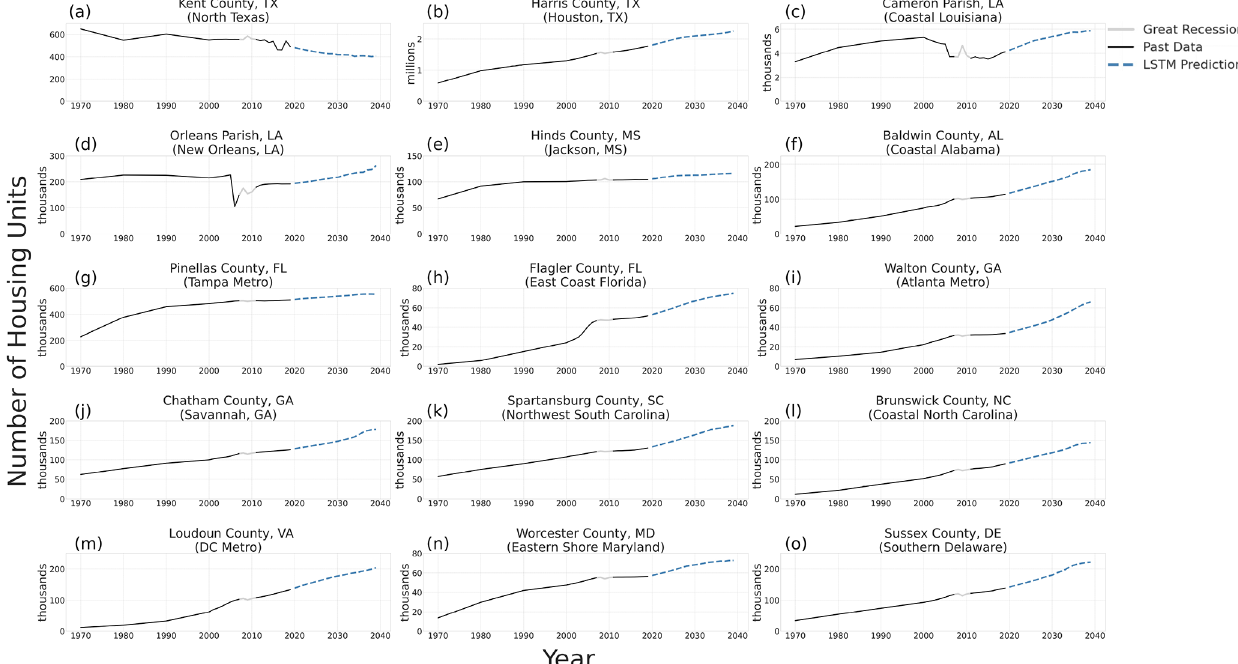
Figure 10. Past and projected number of housing units for 15 counties using the REACH20 model (note the different scales).